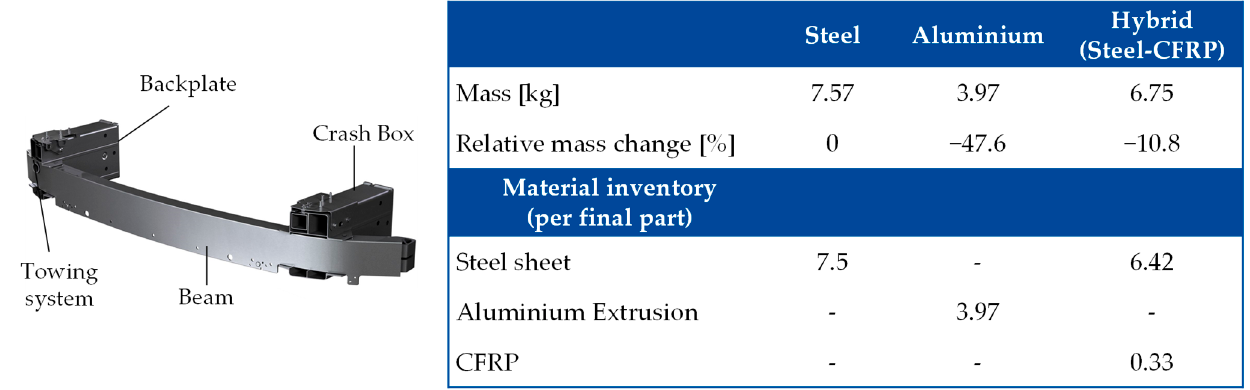
Figure 2. Exemplary CMS ( left ) [56] and weights of design alternatives in this study ( right ). For the hybrid variant, only the beam is designed in a steel-CFRP FML. The other components correspond to those of the steel reference, so the CFRP content is 5 wt.%. The hybrid beam consists of a layered structure of two steel cover layers with a thickness of 0.5 mm each and three layers of CFRP placed in between, consisting of high tenacity (HT) carbon fibres (61 wt.%) and an epoxy resin matrix (39 wt.%). Compared to the beam of the steel version, this results in a weight saving of 26.5%.